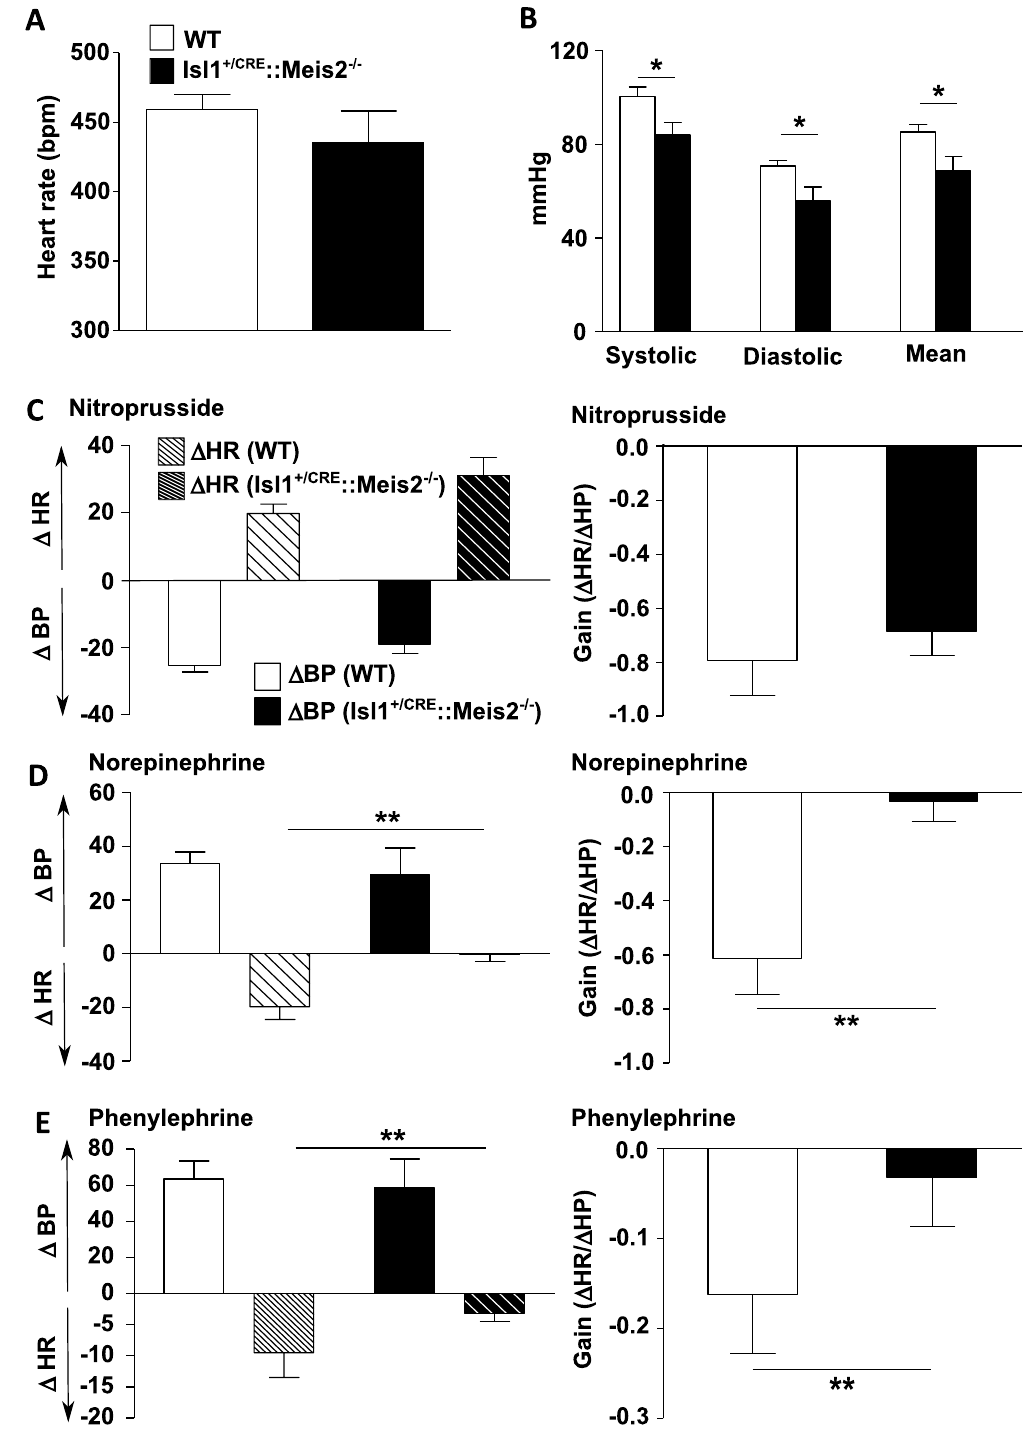
Figure 5. Lack of cardio-inhibitory reflex in Isl1 +/CRE ::Meis2 LoxP/LoxP mice. ( A ) Graphs showing the measurements of the heart rate (RR) in WT and Isl1 +/CRE ::Meis2 LoxP/LoxP anesthetized mice. ( B ) Graph showing measurements of blood pressure in WT and Isl1 +/CRE ::Meis2 LoxP/LoxP mice. The systolic, diastolic and mean blood arterial pressures at baseline are shown. ( C – D ) Graphs showing the variations in mean arterial blood pressure (BP), heart rate (HR) and related gain (ΔHR/ΔBP) following injection of Nitroprusside ( C ), Norepinephrine ( D ) and Phenylephrine ( E ). * p ≤ 0.05; ** p ≤ 0.01 versus WT. n = 6–7 mice in each group. In ( C ), ( D ) and ( E ), plain bars indicate change of heart rate (ΔHR) and dashed bars represents modification in blood pressure (ΔBP). White bars indicate result in WT animal, black bars indicate results observed in Isl1 +/CRE ::Meis2 LoxP/LoxP